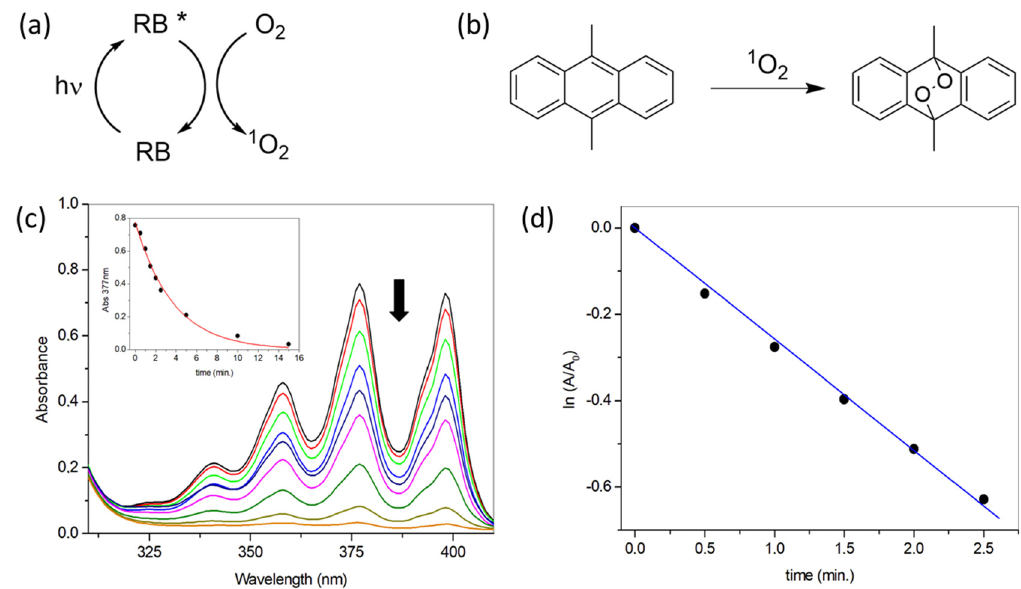
Figure 6. ( a ) Photosensitized generation of 1 O 2 from irradiated RB ; ( b ) DMA reaction with 1 O 2 ; ( c ) Illustrative example of DMA reactivity monitored by UV-vis absorption spectroscopy; ( d ) Illustrative fitting to a pseudo-first order kinetic model, using selected irradiation as an example. Note that to obtain the values shown in Table 1, the procedure was performed by triplicate and the values averaged.